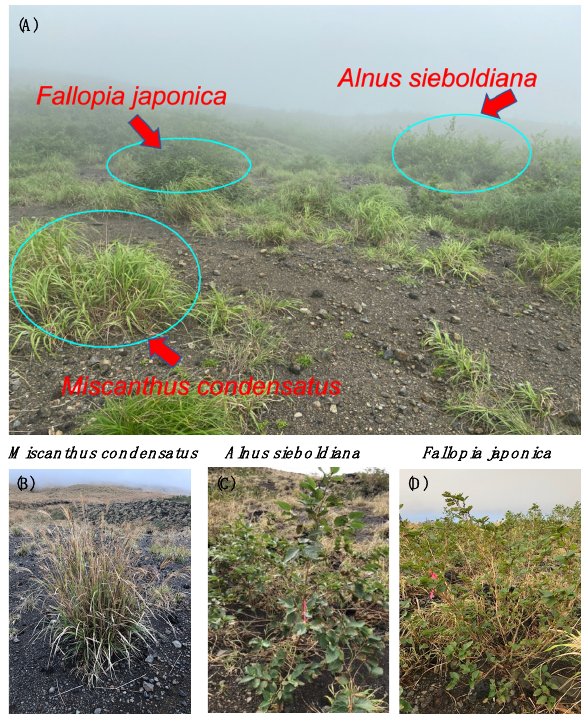
Figure A1. Landscape of study site ( A ) and pictures of the plants Miscanthus condensatus ( B ), Aluns sieboldiana ( C ), and Fallopia japonica ( D ). Table A1. Comparison of leaf trait values (mean ± SE) among the three pioneer species ( n = 15 for each species) (this study) collected from the volcanically devastated site on Miyake-jima Island with the data of same functional type leaves from the GLOPNET dataset (range and mean ± SE) (Wright et al., 2004) and the leaf traits values (mean ± SE) of other pioneer species living in similar habitat conditions. Life form, grass (G), tree (T), herb (H); N-fixing ability, yes (Y), no (N); photosynthetic path- way, C 3 and C 4 . Traits, N area , leaf nitrogen content per area (g·m − 2 ); A max , light saturated photosynthetic rate per leaf area (µmol m − 2 s − 1 ); PNUE, photosynthetic N use efficiency (µmol CO 2 mol N − 1 ·s − 1 ). Shaded cells were used to improve the table readability. Specie/Family/Plant Type/N-Fixing Ability/Photosyn- thetic Pathway